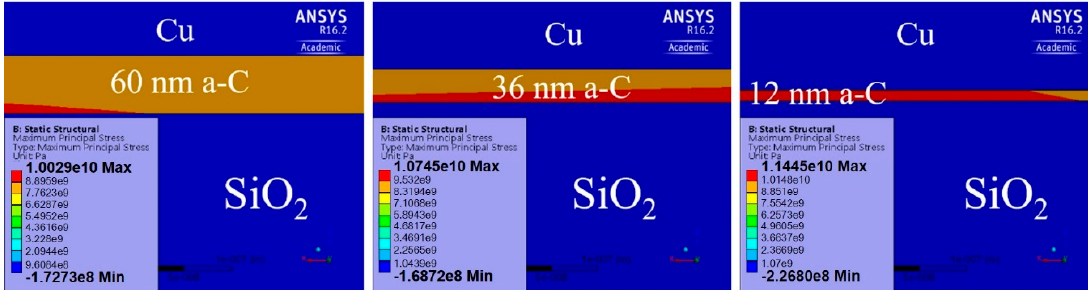
Figure 6. ANSYS simulation results of maximum principal stress distributions in the three samples with different a ‐ C layer thickness at 1020 °C. The area of the maximum stress distribution is the largest in the sample with the thinnest a ‐ C layer.